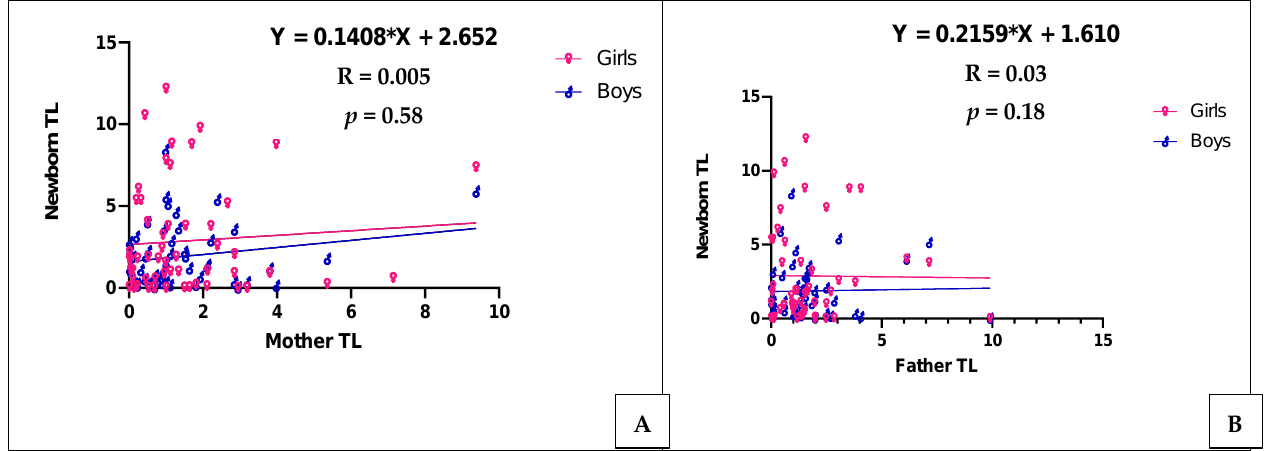
Figure 5. ( A , B ) Linear regression between mother and father TL among genders. No association was found between girls and boys with both parents. The influence of genetics on the heritability of TL from either mother or father was